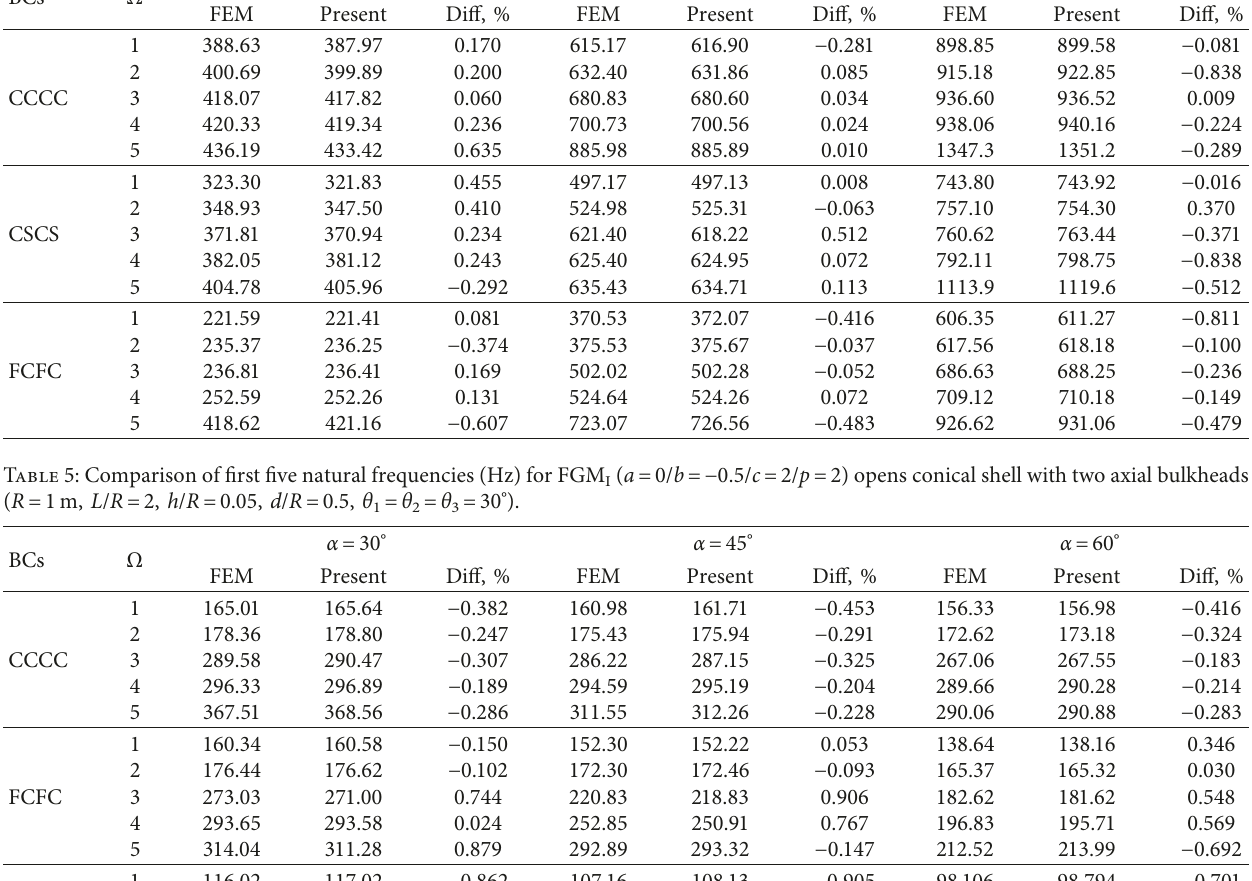
Table 4: Comparison of first five natural frequencies (Hz) for FGM